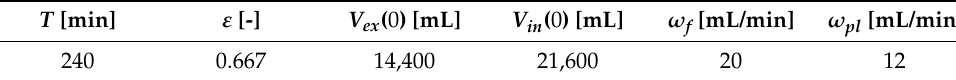
Table 2. Calculation conditions for comparison with clinical